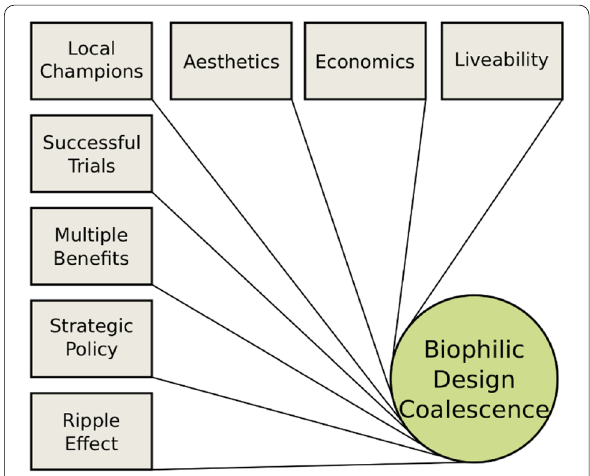
Fig. 3 Prime motivating themes in the coalescent stage. (Source